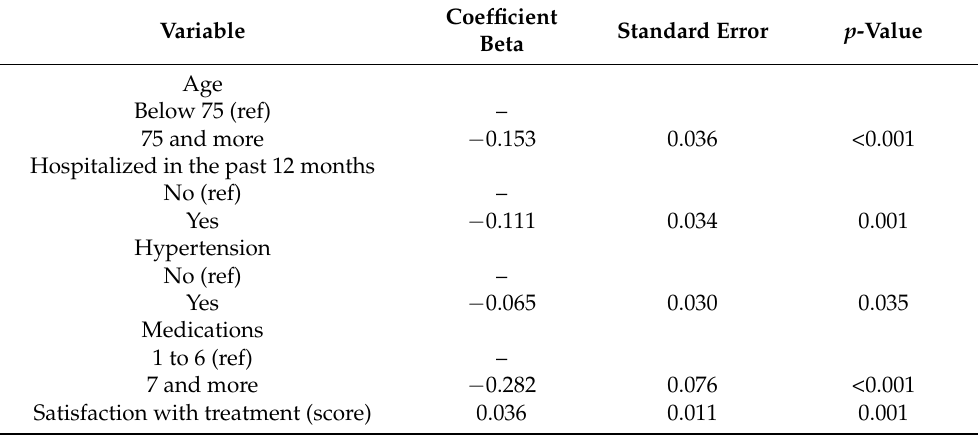
Table 6. A multivariate linear regression of EQ-5D-5L with selected independent